Question: Describe this figure in one sentence.
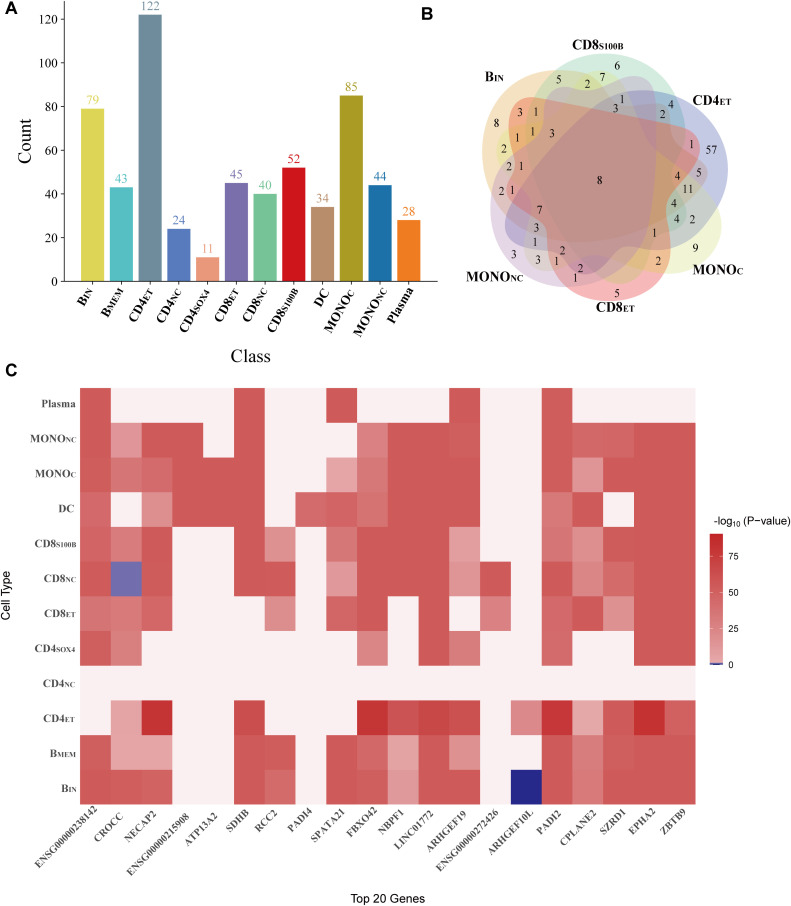
Answer: Summary for the sc-QTL analysis. (A) Bar plot indicates the number of significant genes across each cell type. (B) Heatmaps show the P value for the top 20 genes. (C) Venn diagram representing six cell populations.